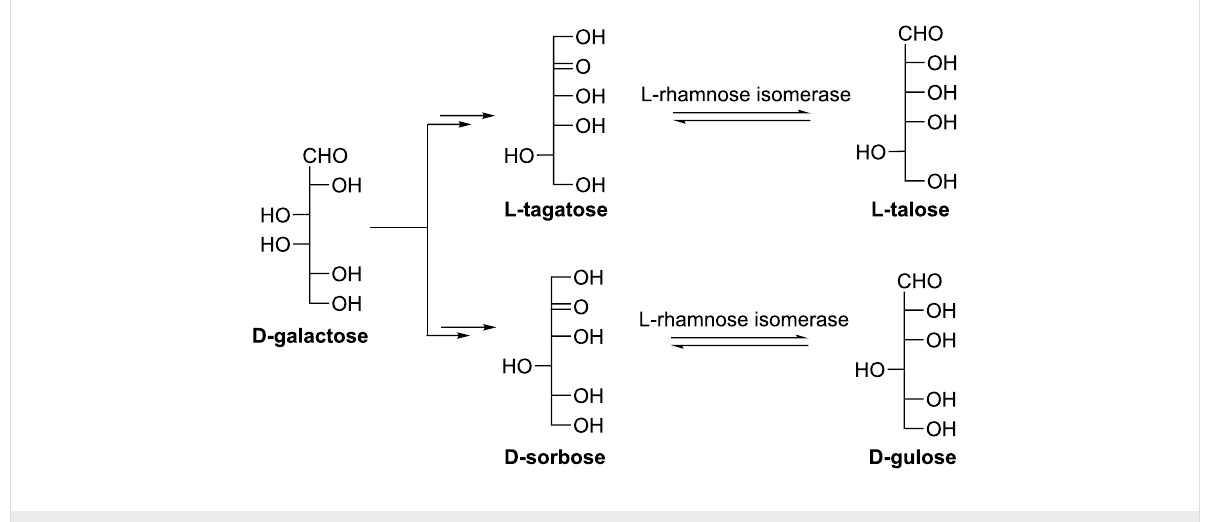
Scheme 14: Enzymatic synthesis of L-talose and D-gulose.